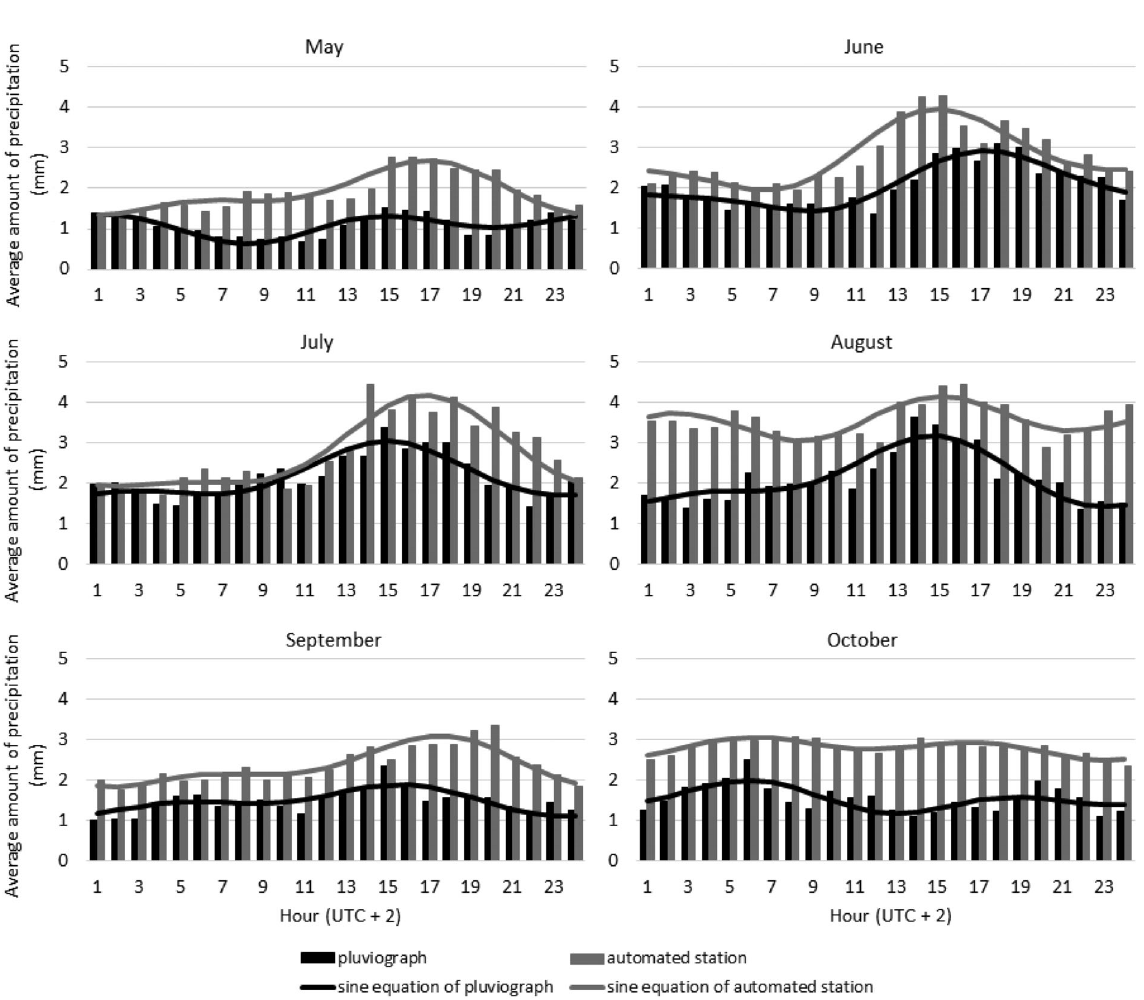
Fig. 5. Mean diurnal distribution of hourly precipitation amounts (mm) in Estonia by months from May to October, calculated from the pluviographic records in 1991–2003 (black columns) and from the automated precipitation gauges in 2003–2013 (grey columns). Thick lines present the approximating diurnal curves of precipitation.